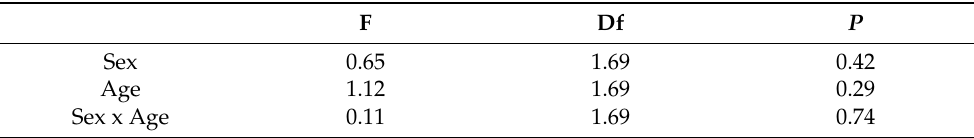
Table 2. Results from the general linear model analysis (GLM) of the variation in monk parakeet maximum distances moved (m) according to the sex and age (juveniles and adults) of the birds. F